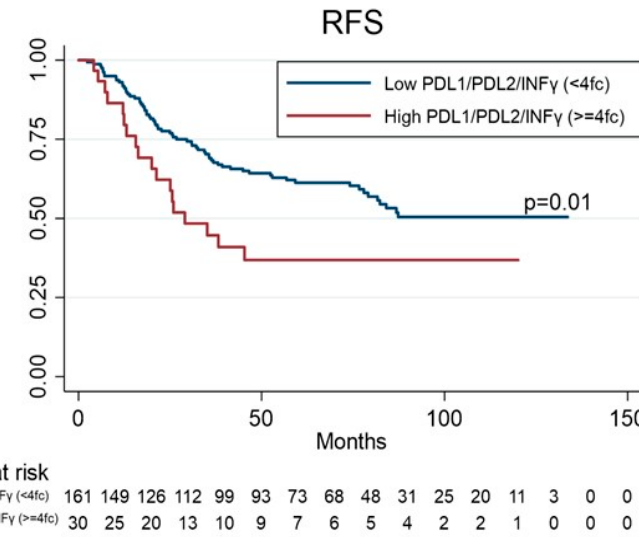
Figure 2. Kaplan–Meier estimates for recurrence-free survival (RFS) according to PD-L1/PD-L2/INF γ co-expression levels. Table 4. Univariate and multivariate analyses for overall survival (OS) (Cox’s proportional hazard regression model).